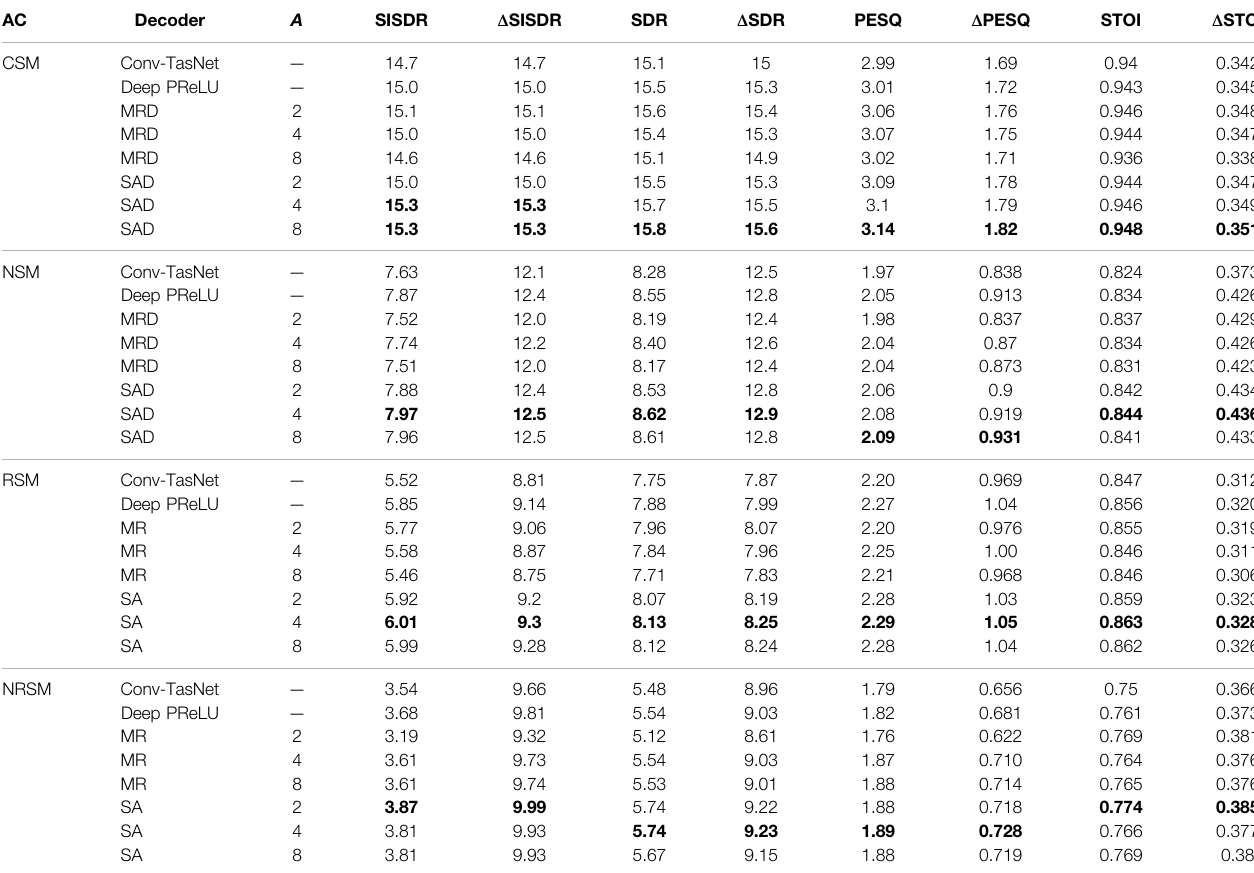
TABLE 5 | Comparison of using 2, 4 and 8 attention heads in MRD ( Figure 7a ) against the original Conv-TasNet decoder proposed by Luo and Mesgarani, (2019). Bold indicates the best performing model for each acoustic condition and metric.